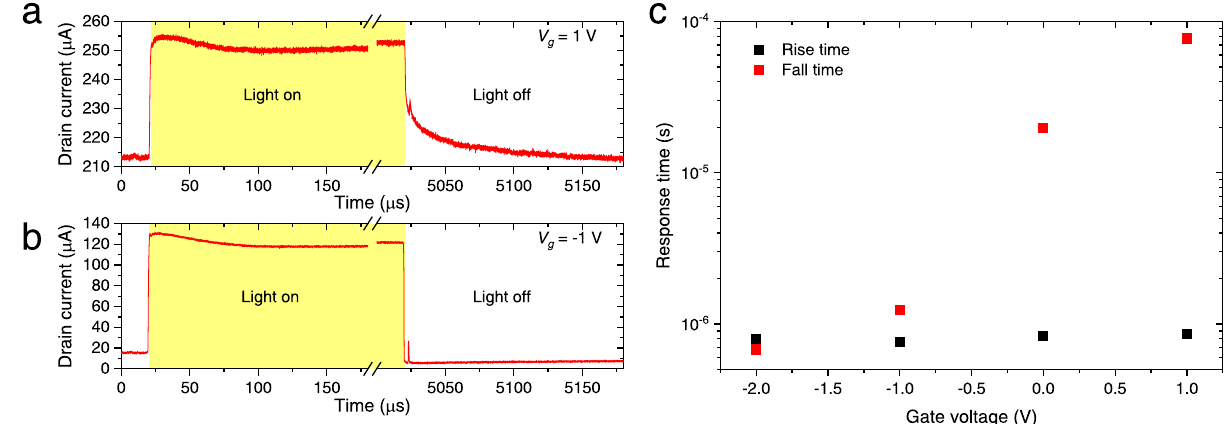
Fig.4|Timeresponseofawaveguide-coupledInGaAsphototransistor.a Timeresponseof I d with V g of1V. b Timeresponseof I d with V g of − 1V. c Risetimeandfalltime as a function of V g